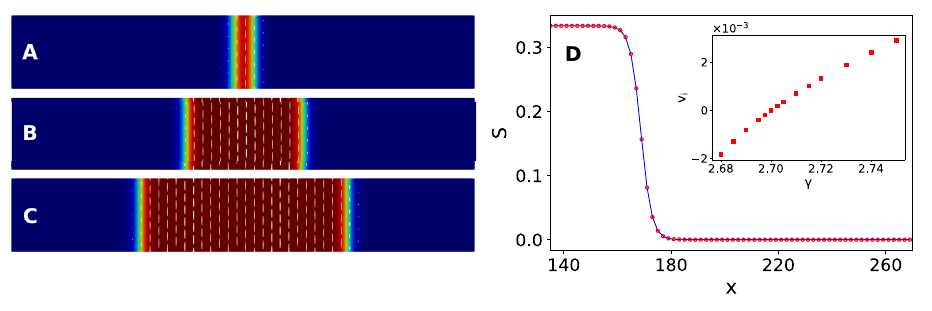
Figure 1. Order parameter for flat interfaces at di ff erent temperatures and at time t = 350000: A) γ = 2 . 699, B) γ = 2 . 7, C) γ = 2 . 701. The velocity field is below the machine precision everywhere for γ = 2 . 7. D) Scalar order parameter at y = L / 2. The solid line is the analytical expression given by Y Eq. (10) for S n = 1 / 3 and λ = 2 and the circles are the simulated results. The inset shows the interface velocity at di ff erent temperatures. At coexistence γ = 2 . 7, the interface velocity is below the machine